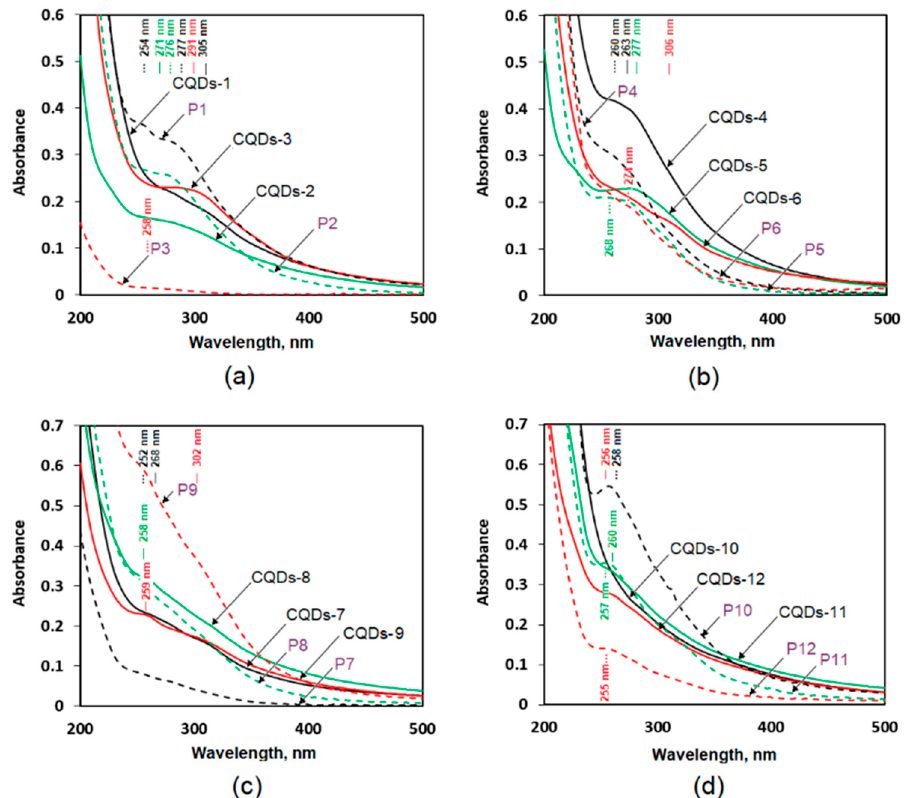
Figure 2. UV-Vis spectra of the obtained CQDs and their permeates ( a ) CQDs1-3 samples and their permeates, ( b ) CQDs4-6 samples and their permeates, ( c ) CQDs7-9 samples and their permeates and ( d ) CQDs-10-11 samples.